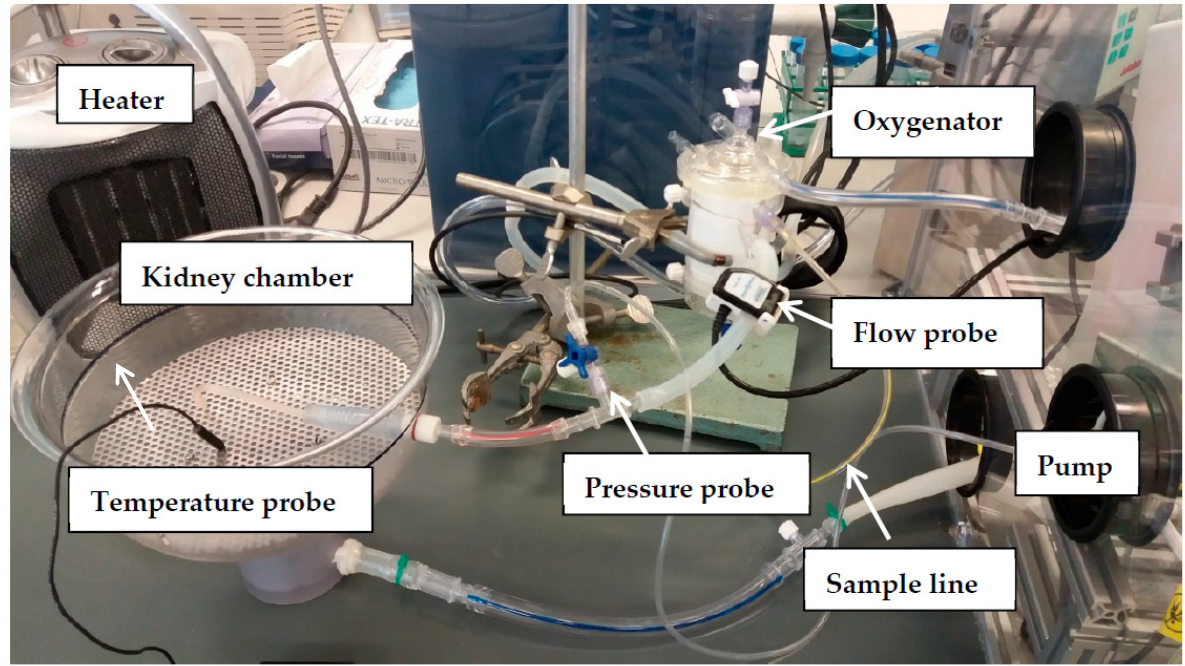
Figure 2. The normothermic perfusion circuit.